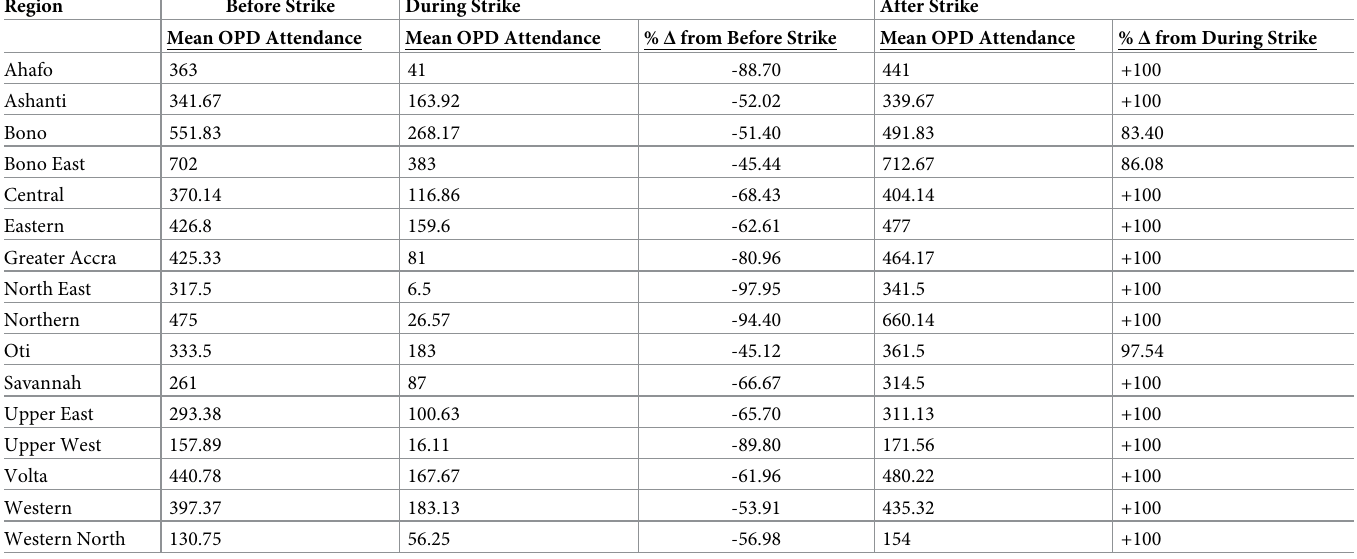
Table 2. Percentage change in the mean OPD attendance during and after strike.